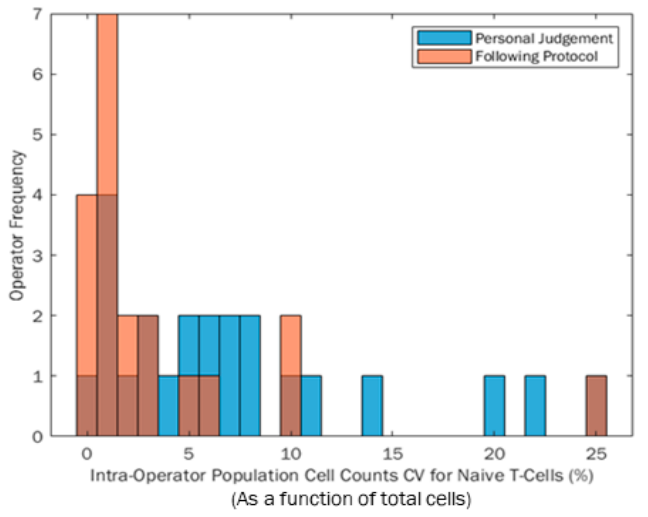
Figure 4. Histogram of participant CVs when repeat gating has the same data using their own judgement (blue bars) and then following a protocol (orange bars). Participant measurement uncertainty was calculated by combining the SDs from each gate in quadrature as described in the methodology Equation (1). Figure 5 shows the distributions of these participant expanded uncertainties (U) when gating based on their own judgement (blue) and following the protocol (orange). Darker areas on the